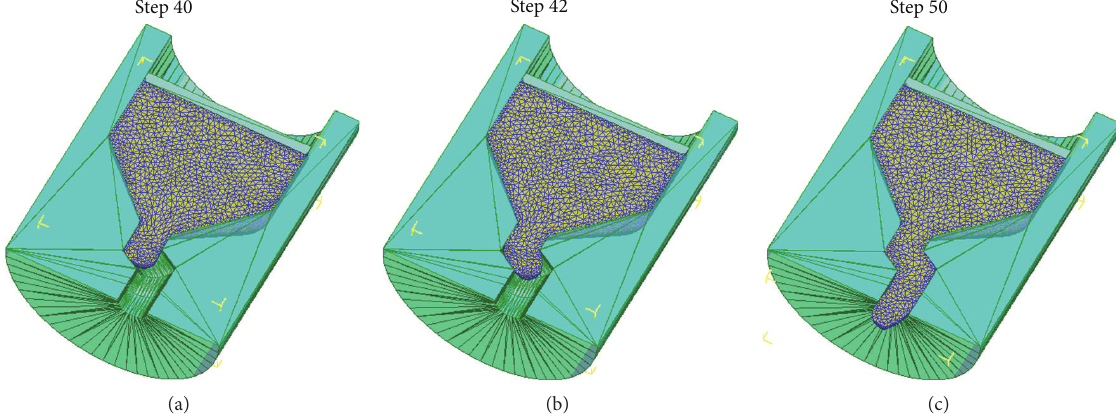
Figure3:AZ31materialflowforESprocess,extrusionstagesofESdie:(a)directionextrusionstage,(b)firstshearing,and(c)secondshearing.